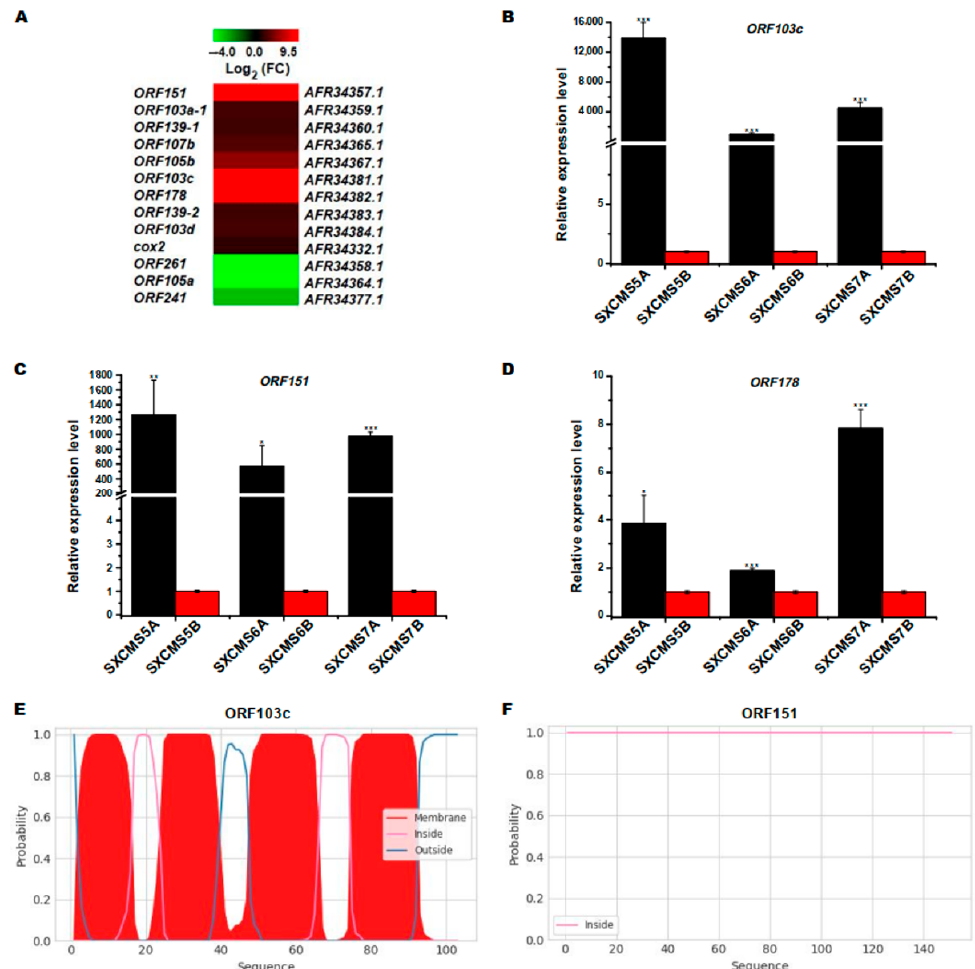
Figure 4. Analysis of DEGs in mitochondrial genome between soybean CMS lines and their maintainer lines. ( A ) Heat map of DEGs in mitochondrial genome between SXCMS5A and SXCMS5B. The heat map was conducted using MeV 4.9 software. Log 2 (FC) values were obtained from the RNA-seq data. ( B – D ) Relative expression level of ORF103c , ORF151 and ORF178 between soybean CMS lines and their maintainer lines. by qRT-PCR analysis. Asterisk indicated statistical significance: *, p < 0.05; **, p < 0.01; ***, p < 0.001. ( E , F ) Transmembrane domain analysis of ORF103c and ORF151. The abscissa indicated the amino acid length of ORFs. The ordinate represented the probability of the predicted transmembrane domain.